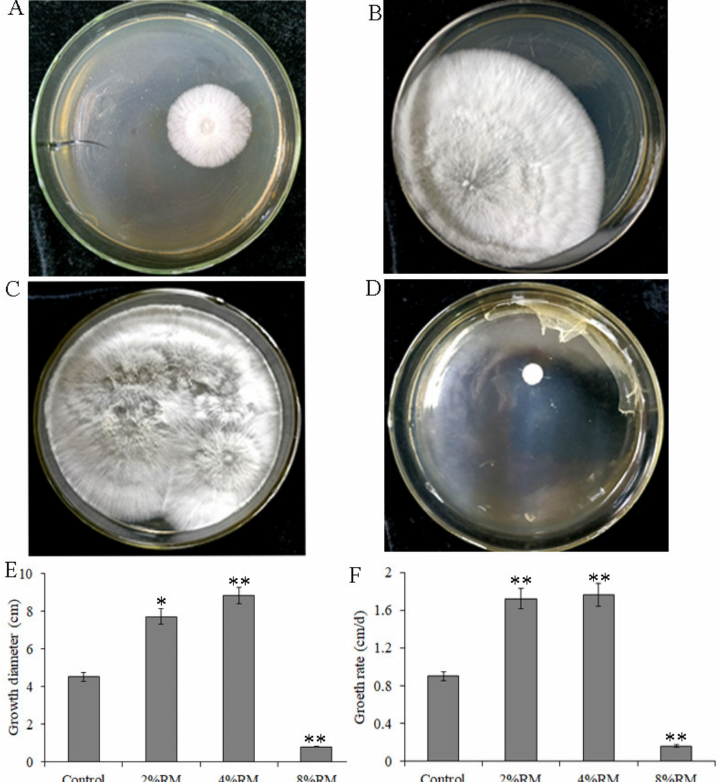
Figure 3. Growth of P. ostreatus mycelia on a potato dextrose agar (PDA) medium with different concentrations of R . roxburghii must (RM). ( A ): control group (without must); ( B ): 2% RM ( v / v ); ( C ): 4% RM ( v / v ); ( D ), 8% RM ( v / v ); ( E ): diameter of mycelia on the PDA medium with different concentrations of R . roxburghii must; ( F ): growth rate of mycelia on the PDA medium with different concentrations of R . roxburghii must. * indicates a significant difference at p < 0.05 compared with the control group; ** indicates a significant difference at p < 0.01 compared with the control